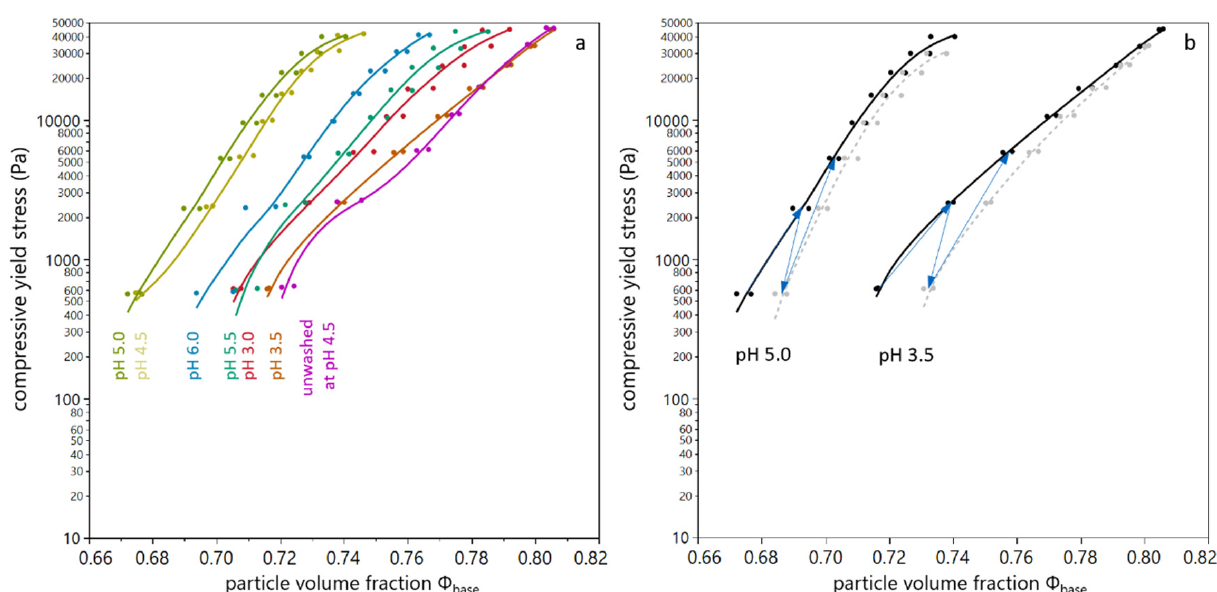
Figure 4. Compressive yield stress and particle volume fraction in the sediment during analytical centrifugation of yeast suspension for different pH values and buffers ( a ). The progression of compression and relaxation are indicated as a change of compressive yield stress and particle volume fraction in the sediment ( b ), where black dots indicate values after the compression step, grey dots indicate values after the decompression step and blue arrows indicate the chronological order of the single steps. The values of each duplicate measurement are given as individual dots. The lines are a guide to the eye.